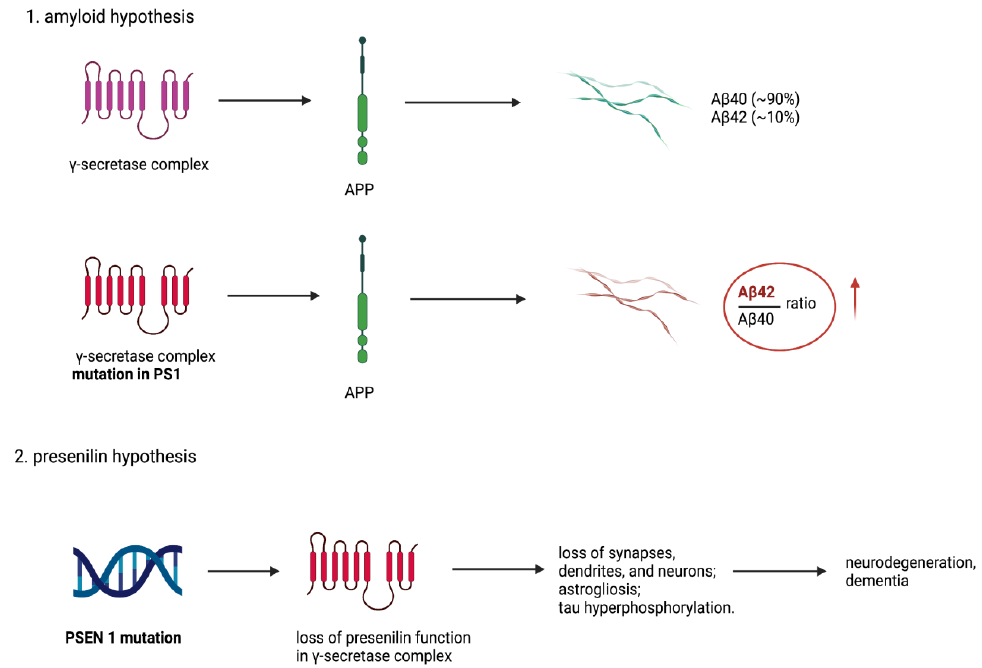
Figure 1. The comparison between amyloid and presenilin hypotheses. The amyloid hypothesis proposed that mutation in PSEN1 results in presenilin dysfunction, thus change in γ -secretase activity resulting in relative increase of the Aβ42/Aβ40 ratio, which is significantly increased in AD pathologies. The presenilin hypothesis does not exclude the amyloid hypothesis but complements it. It presents theory that PSEN1 mutation and following loss of presenilin normal activity in brain triggers neurodegeneration and dementia also without coexisting amyloid formation. Created with BioRender.com.